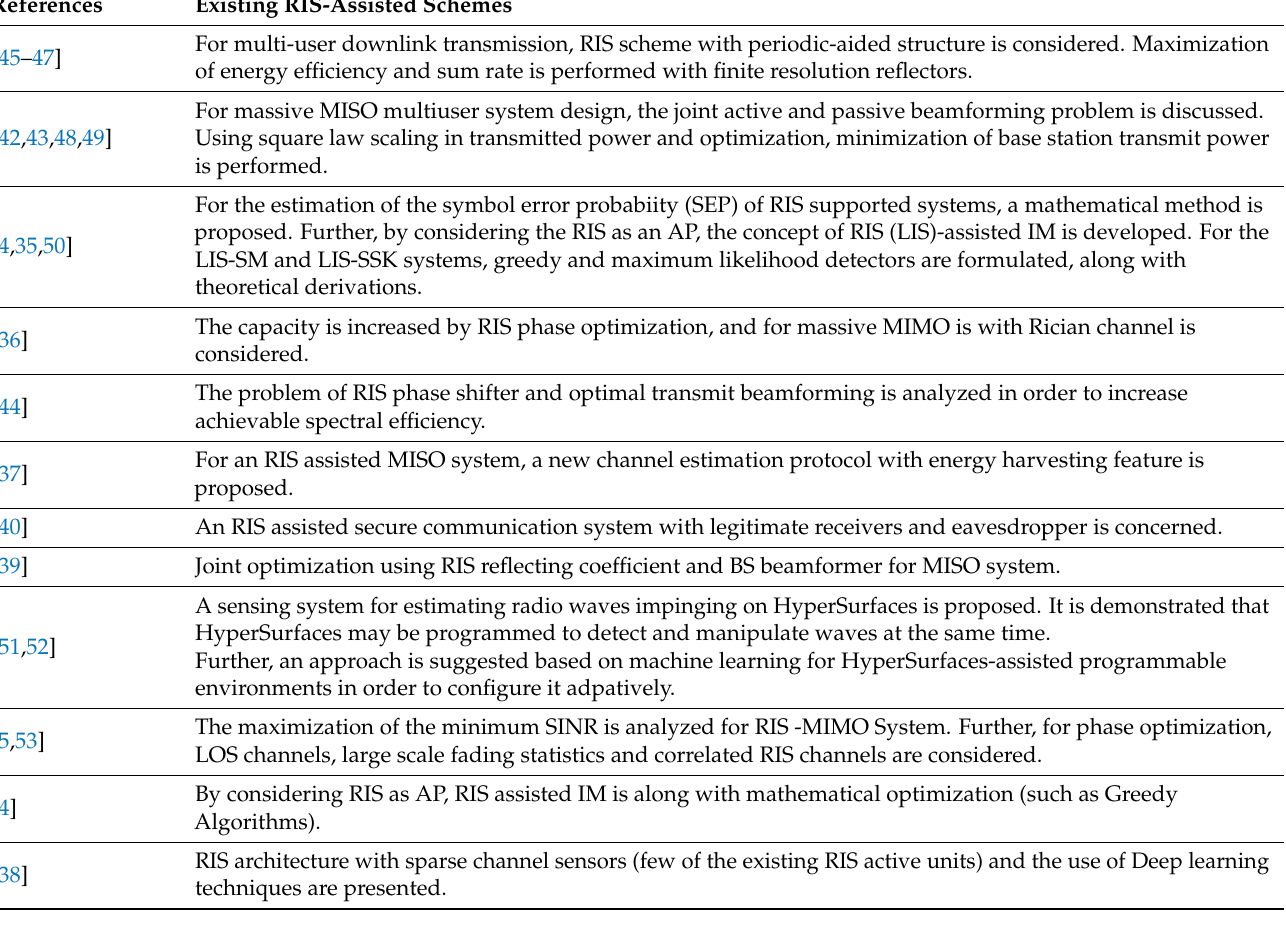
Table 2. Recent state of the art for RIS-assisted